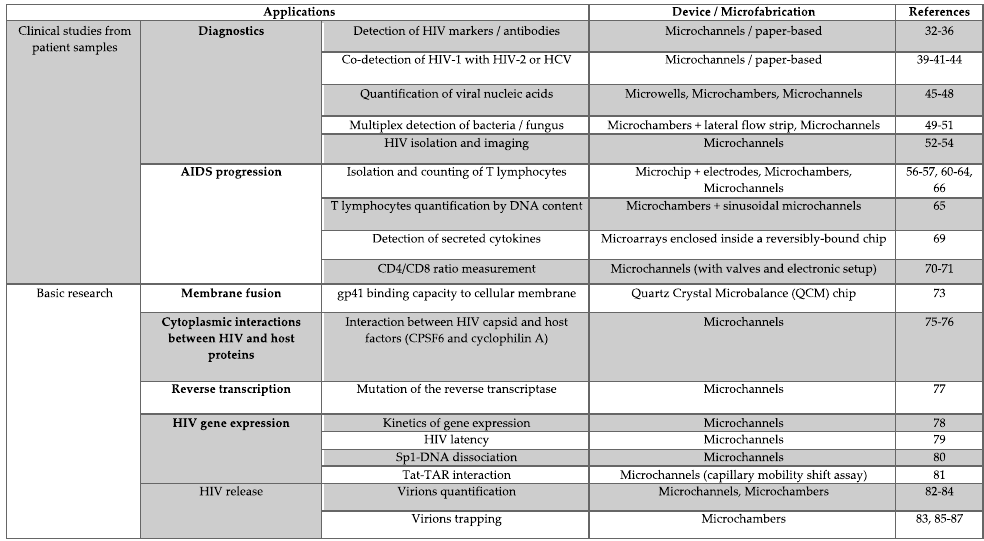
Figure 2. Summary of the different microfluidic devices developed in HIV infection.